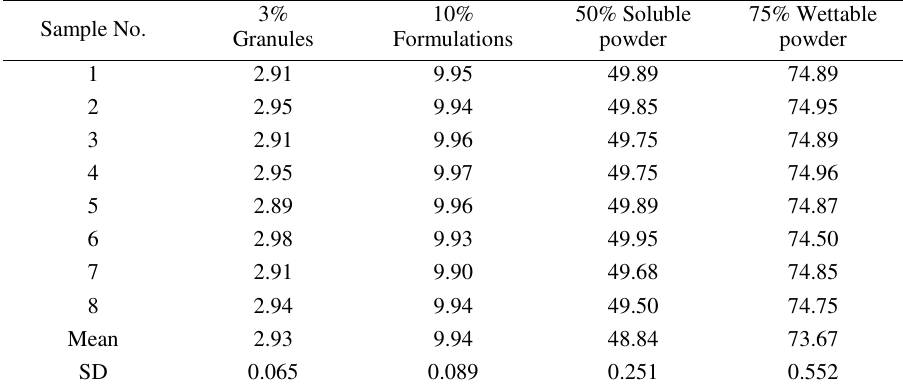
Table 3. Determination of carbofuran in insecticidal formulations using 4-methylaniline as a coupling agent.